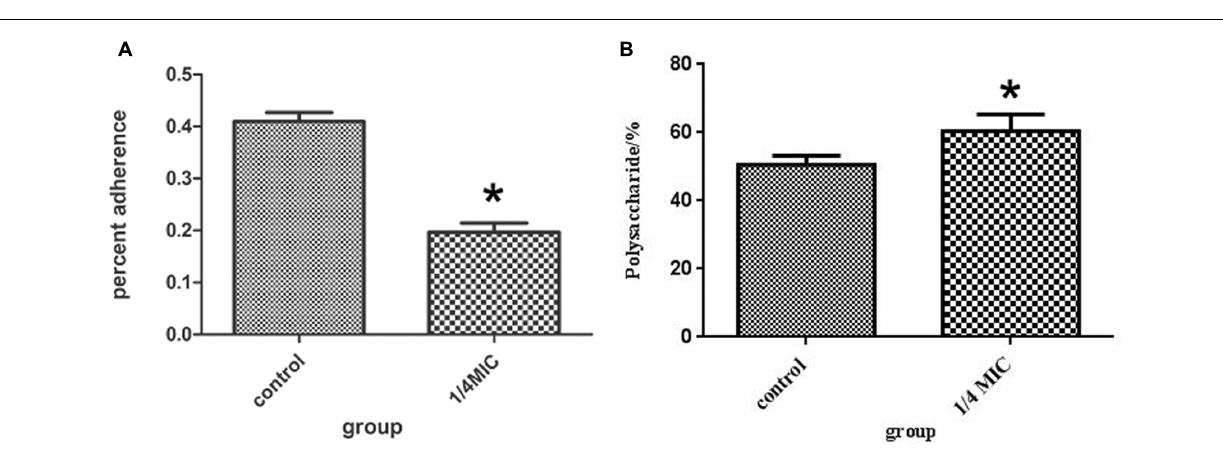
FIGURE 3 | Effect of rutin on S. suis biofilm by scanning electron microscope. Biofilm formation of S. suis without rutin (A) . Biofilm formation of S. suis with 1/4 MIC (0.0781 mg/ml) rutin treatment (B) .